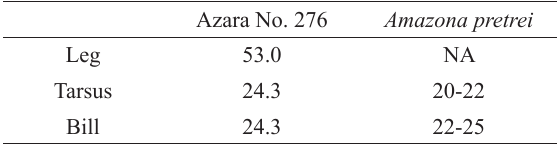
Comparative measurements of Azara No. 276 and Amazona pretrei in mm . Measurements for Amazona pretrei from Juniper & Parr (1998). A line, the unit used by Azara, is equivalent to 2.21